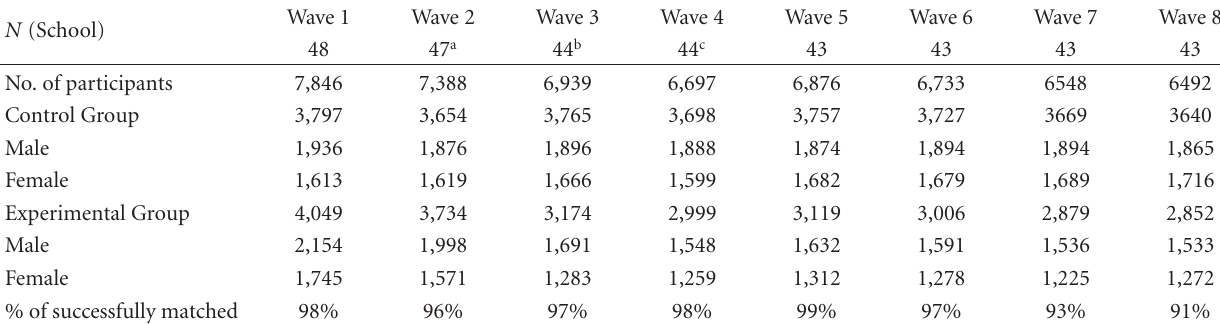
Table 1: Number of collected questionnaires across waves.